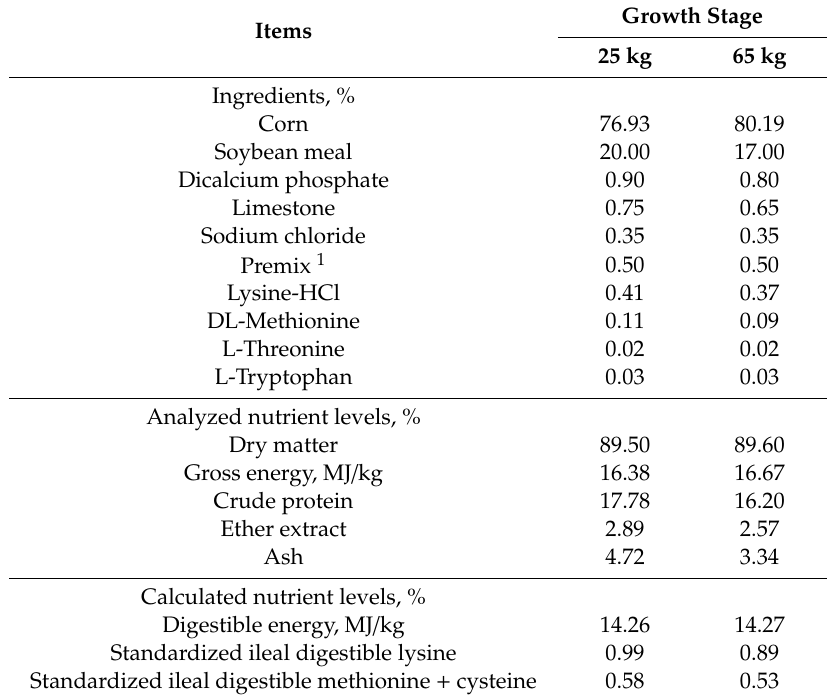
Table 1. Ingredient compositions and analyzed chemical components of the complete diets fed to barrows at di ff erent growth stages used in Trial 1 and Trial 2 (as-fed basis). Growth Items